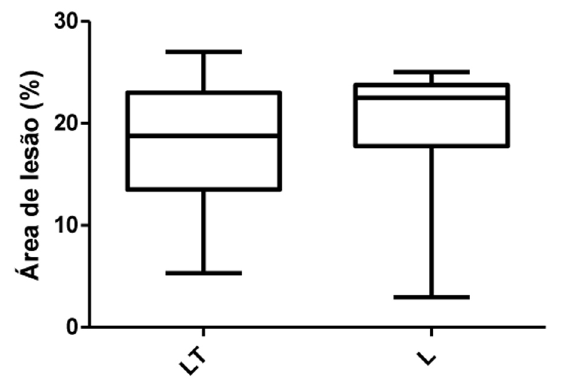
Figure 1 - Box plot, median and interquartile range values ) of the injured treated group (LT) and injured untreated group